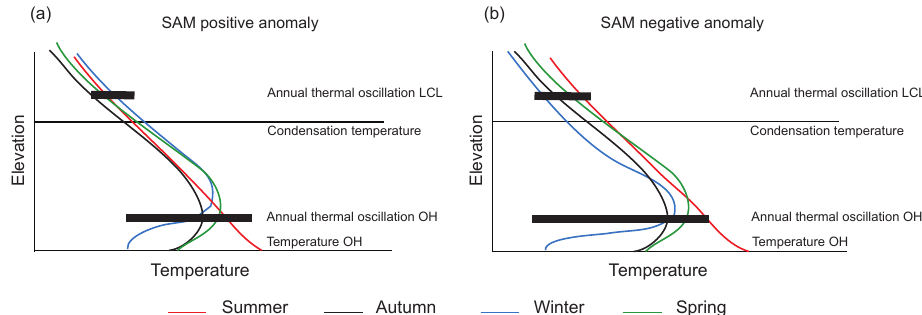
Figure 16. Sea level to Laclavère Plateau temperature oscillation scheme during summer (DJF), autumn (MAM), winter (JJA) and spring under (a) positive SAM anomaly conditions and (b) negative SAM anomaly